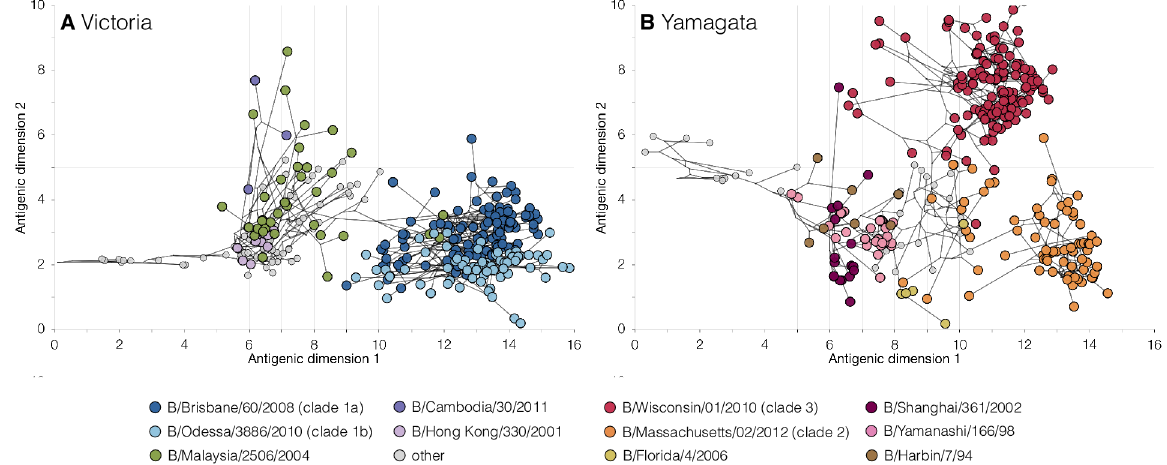
Fig 4. Antigenic and genetic evolutionary relationships of influenza B viruses. Antigenic maps of (A) 309 Victoria- and (B) 308 Yamagata- lineage viruses shown in 2 antigenic dimensions over time (1987–2013), inferred by BMDS using HI titer data and HA sequences. Each circle indicates a virus antigenic map location and lines represent phylogenetic relationships inferred between viruses.